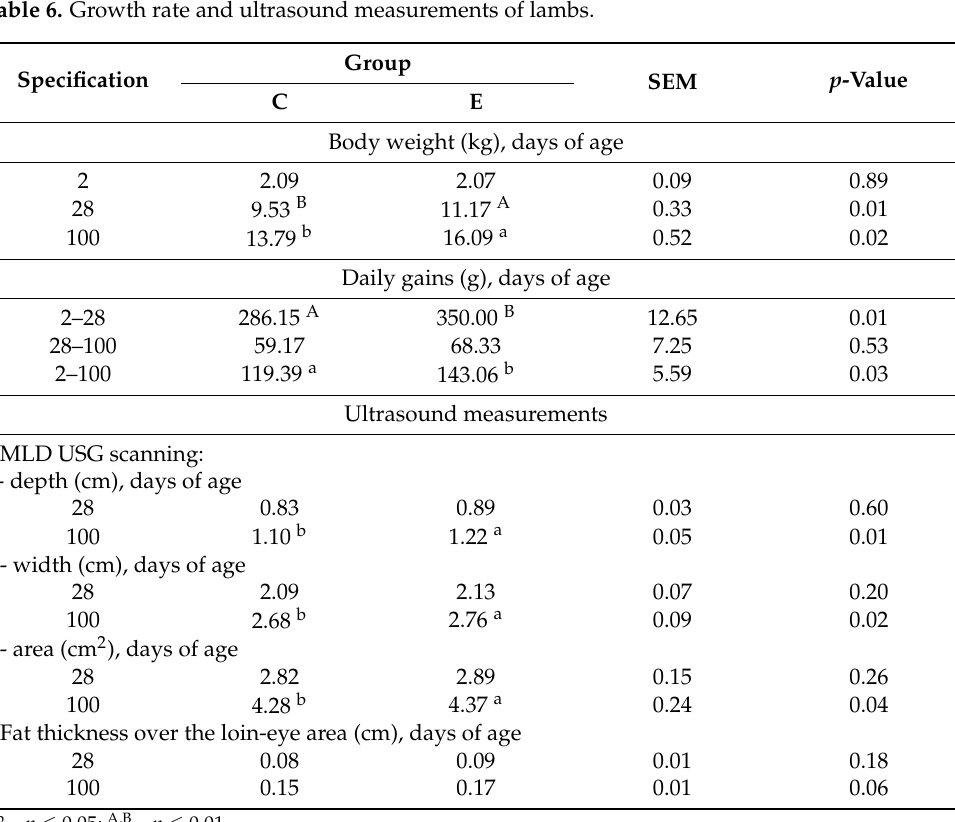
Table 6. Growth rate and ultrasound measurements of